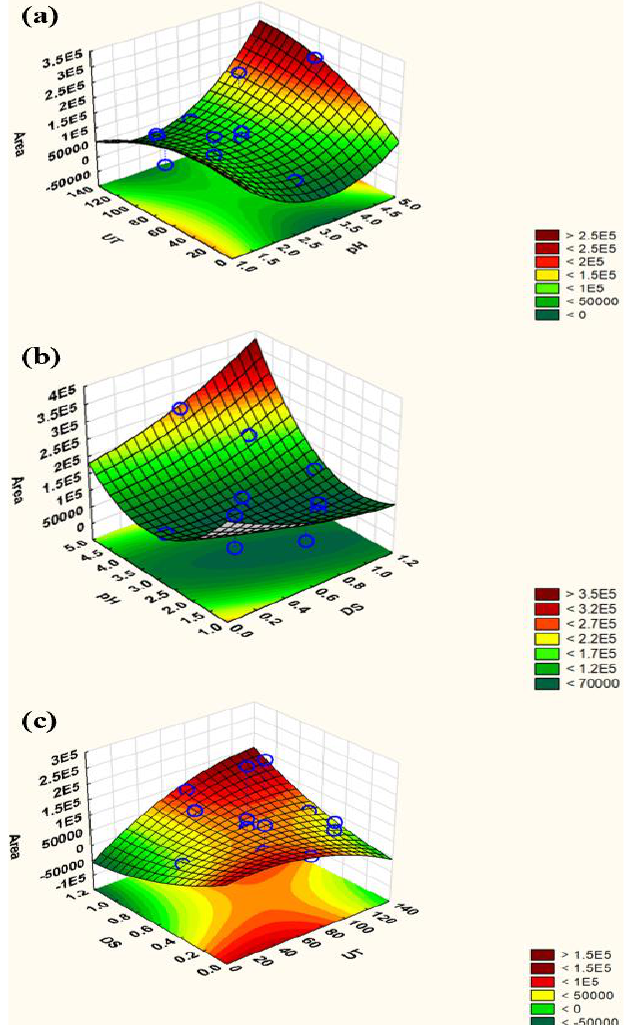
Figure 3. Response surface plots: ( a ) pH vs. ultrasonication time; ( b ) volume of disperser solvent vs. pH; ( c ) ultrasonication time vs. volume of disperser solvent.